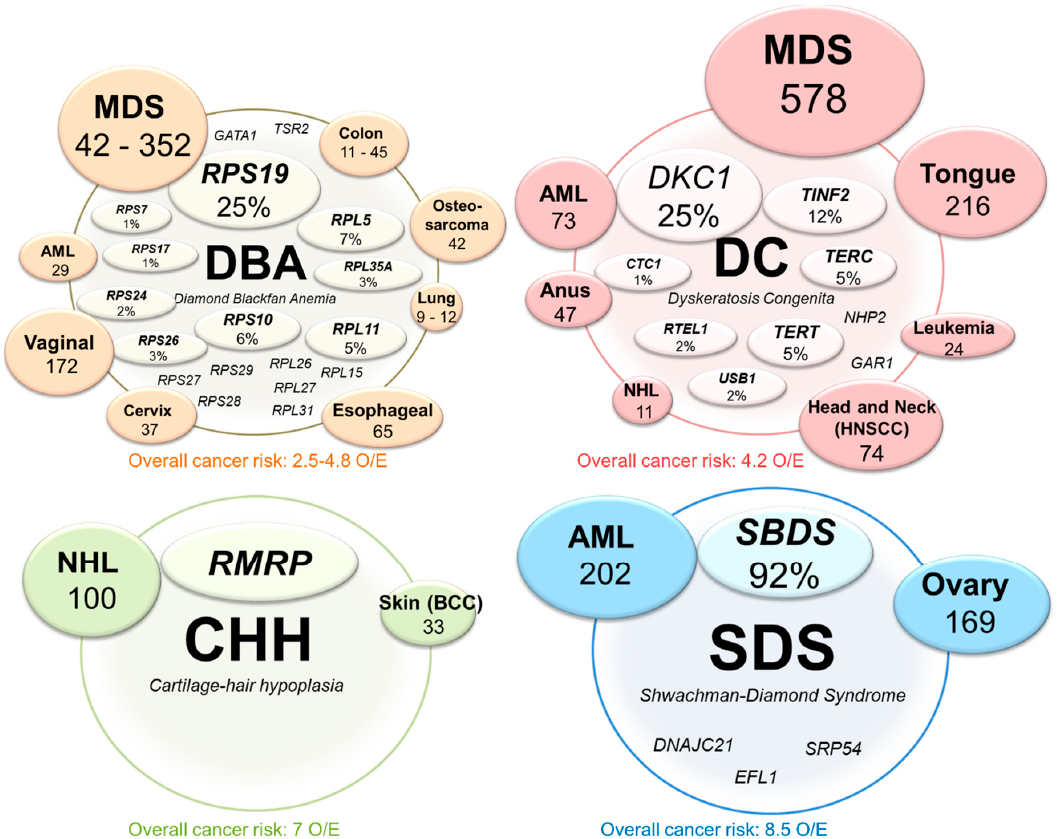
Figure 2. Overview of the most common mutations and associated cancer risks in congenital ribosomopathies. The genes that are mutated or deleted in Diamond Blackfan anemia (DBA), dyskeratosis congenita (DC), cartilage-hair hypoplasia (CHH) and Shwachman–Diamond Syndrome (SDS) are indicated in the lightly shaded inner circles. The reported percentages indicate the fraction of patients with that ribosomopathy that presents a genetic defect in the corresponding gene. When the exact incidence of the defects are unknown, only the gene name is indicated. The outer, darker circles report the cancer types that occur at a significantly higher incidence in the shown ribosomopathy as compared to the healthy population. The size of the circles and the number reported below each cancer type represents the observed over expected (O/E) ratio and quantifies the risk increase for that particular cancer type in each ribosomopathy. Below the circle of each ribosomopathy, the overall cancer risk (O/E ratio) is reported.